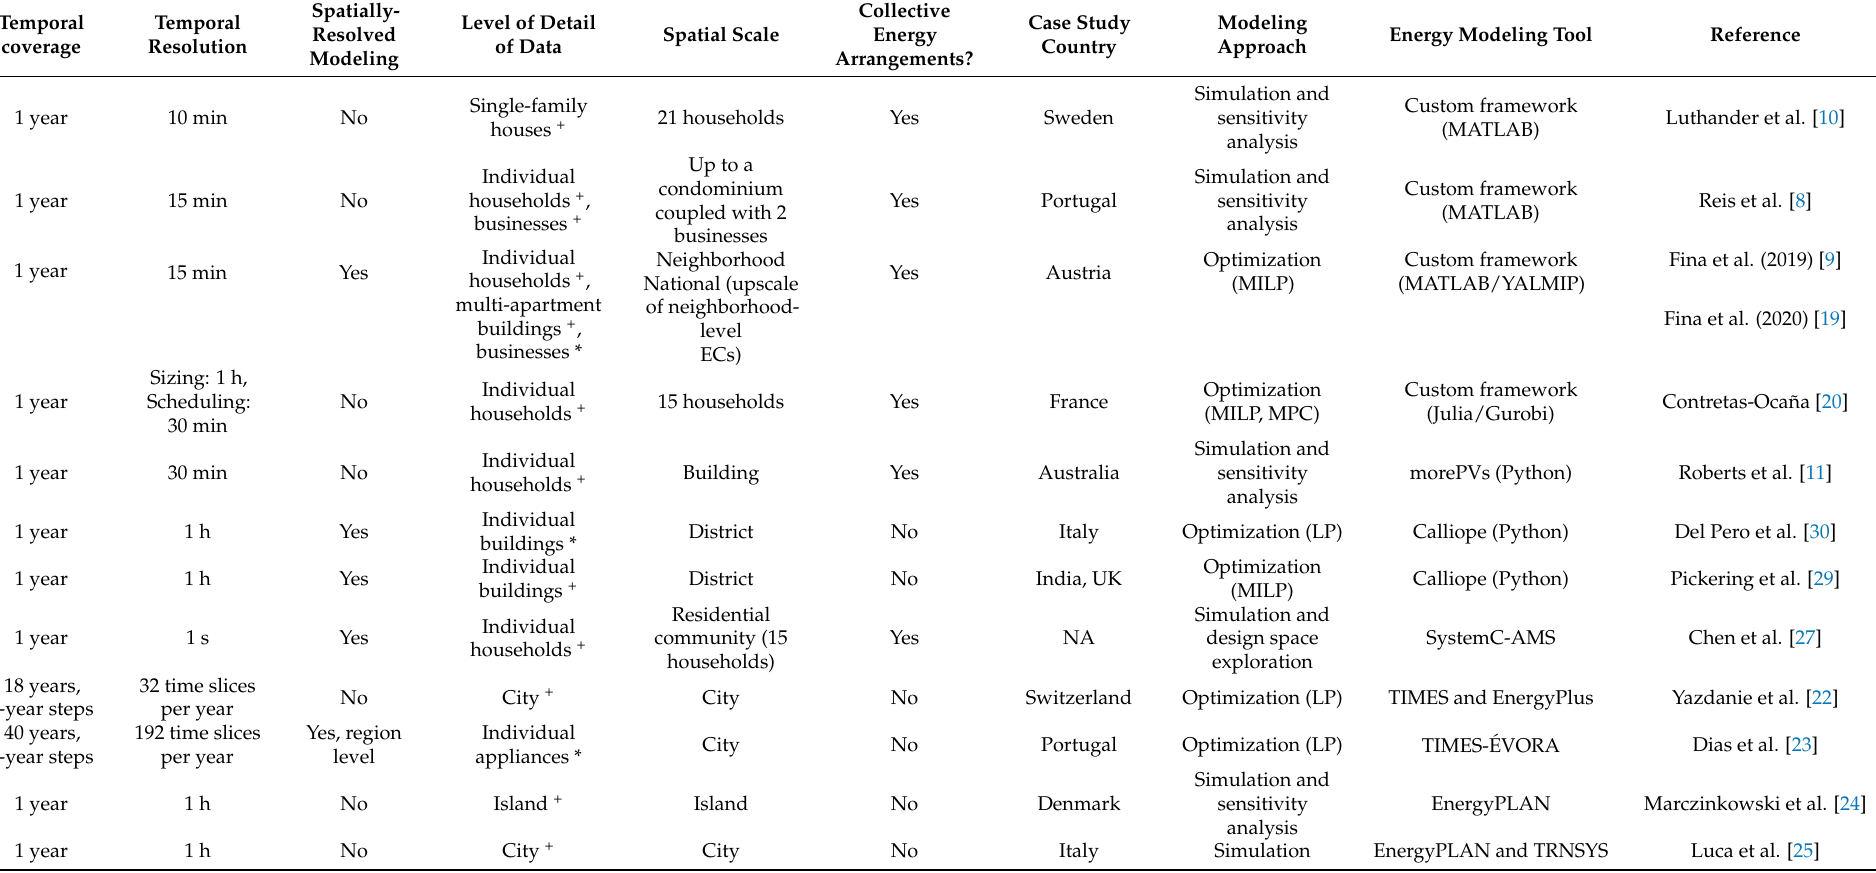
Table 1. Detailed comparison of the reviewed literature (continues on the next